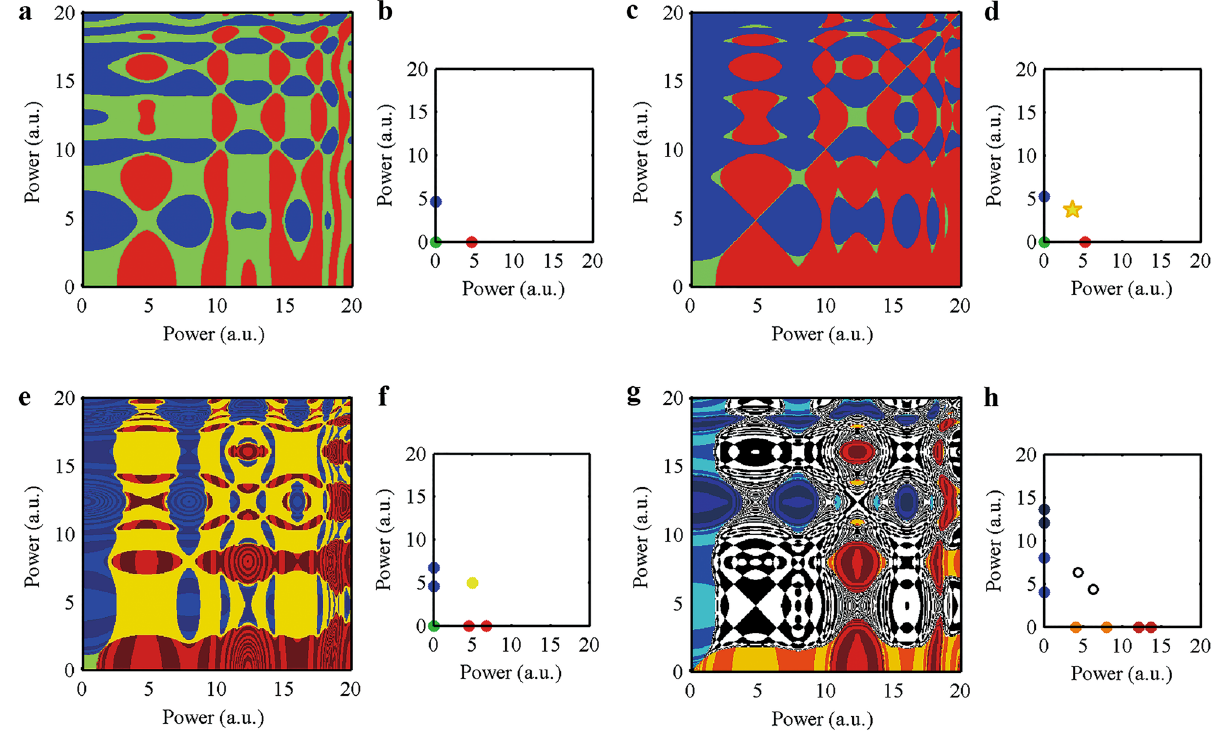
Figure 6. The attractors and attractor-basin phase portraits for different gain coefficients. Any initial condition is a point in phase space. A square region for possible initial condition in phase space is subdivided into 500 × 500 cells. We perform the iteration and track the points on the grid until the attractors are obtained. Then, we can derive the attractor basin. Different colours correspond to different attractors. ( a , c , e and g ) are attractor- basin phase portraits for different gain coefficients (g 0 ); ( b , d , f and h ) are attractors for ( a , c , e and g ). For Fig. 6. ( a and b ), g 0 = 1.7. There are three attractors in ( b ) (blue, red and green points). The blue point and the red point are stable single-pulse state. The green point indicates no pulse. The attractor basins for the attractors are shown in ( a ) (use the same colour as the corresponding attractor in ( b )) For Fig. 6. ( c and d ), g 0 = 2.0. There are four attractors in ( d ) (blue, red, green and yellow points). The blue point and the red point are stable single-pulse states. The green point indicates no pulse. A new attractor (the point with yellow star marker) means that the laser can support 2 pulses under a narrow range of initial conditions. For Fig. 6. ( e and f ), g 0 = 2.5; There are four attractors in ( f ) (blue, red, green and yellow points). The blue points and the red points are single-pulse in periodic fluctuation state. The green point indicates no pulse. The yellow point indicates stable double pulses. For Fig. 6. ( g and h ), g 0 = 3.0; There are three attractors in ( h ) (blue & dark blue, orange & red, black circle). The blue & dark blue points and the orange & red points are single-pulses in a periodic fluctuation state. The black circle is for double pulses in a periodic fluctuation